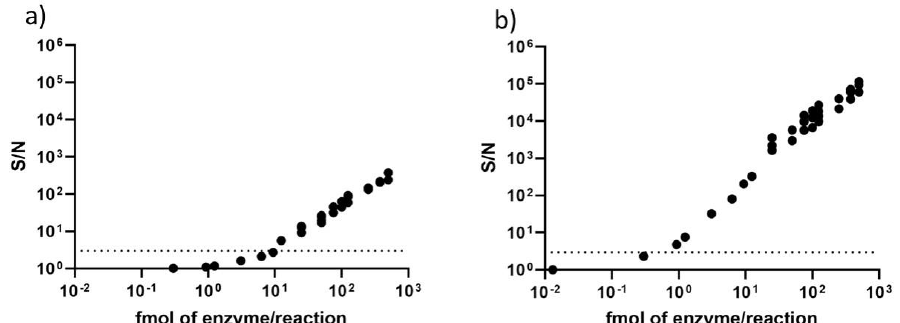
Figure 2. Signal-to-noise ratio (S/N) versus the amount of enzyme. ( a ) ALP*/DynaLight and ( b ) NLuc/Nano-Glo. S/N of 3:1 is indicated by a dashed line (n = 3).